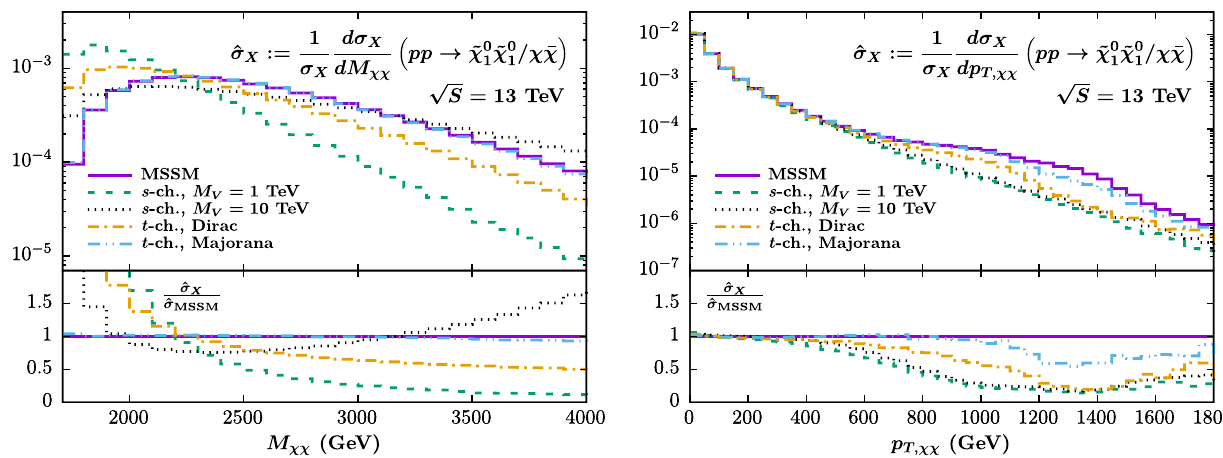
Fig. 10 Invariant mass (left) and the transverse momentum distribution (right) of the DM pair system at NLO+PS accuracy. Masses and parameters are chosen according to the ˜ b parameter point of Fig. 7. The coloring of the lines follows the scheme introduced in Fig. 9